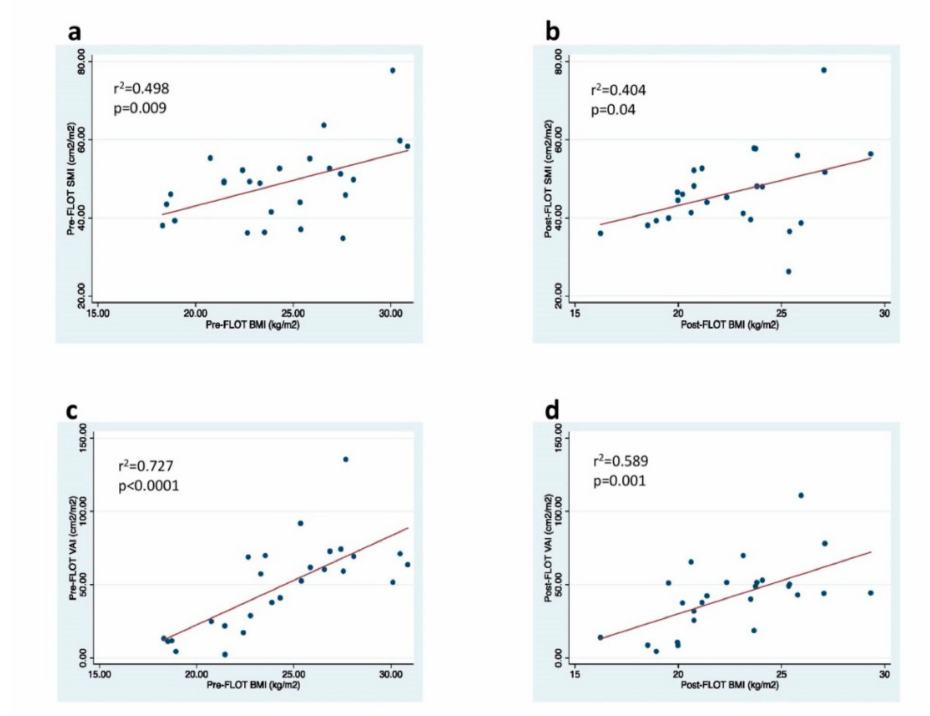
Figure 3. Correlation between BMI, SMI, and VAI before and after pre-surgical FLOT chemotherapy in patients with GC. Pearson correlation changes in ( a ) pre-FLOT BMI and SMI, ( b ) post-FLOT BMI and SMI, ( c ) pre-FLOT BMI and VAI, ( d ) post-FLOT BMI and VAI. Abbreviations: BMI, body mass index; FLOT, fluorouracil plus leucovorin, oxaliplatin, and docetaxel; r, Pearson’s linear correlation coefficient; SMI, skeletal mass index; VAI, visceral adipose